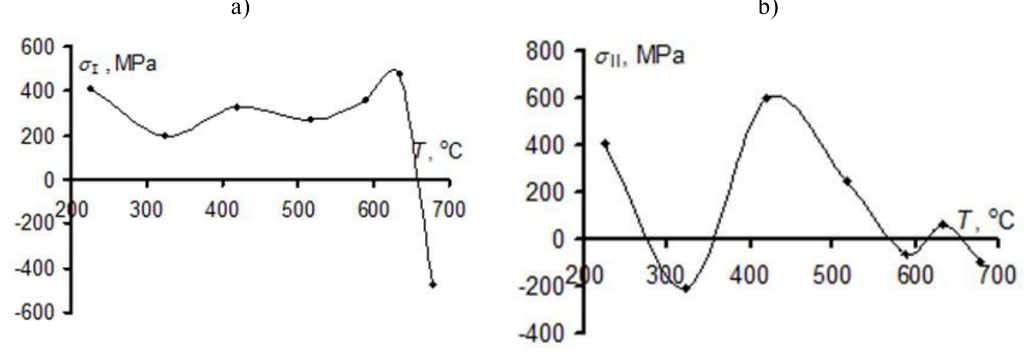
Figure 2. Microstresses depending on the temperature (steel 12H1MF): a – microstresses of the I st kind, b – microstresses of the II nd